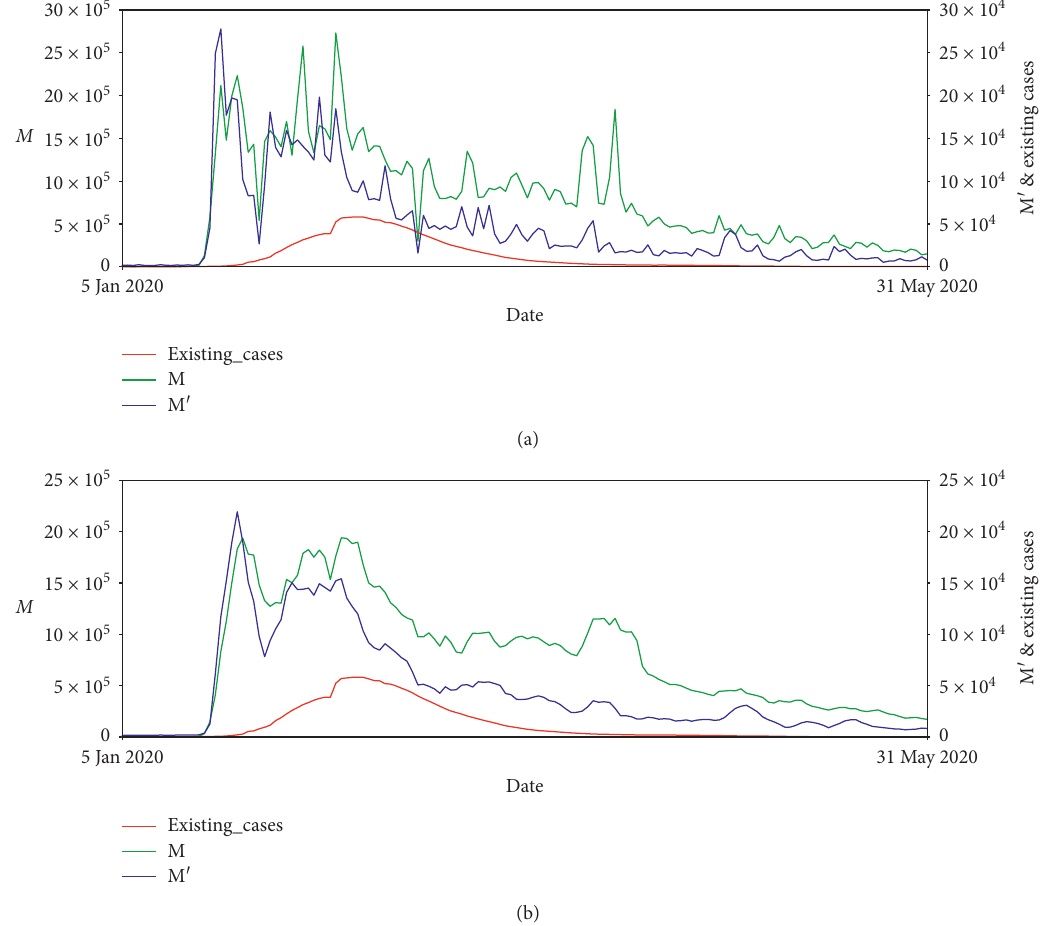
Figure 1: (a) Number of existing cases of COVID-19 in China (red line), number of discussions about COVID-19 (M) (green line), and disinfection on Sina Weibo (M’, blue line). (b) Smoothed curves in (a) using nonoverlapping windows, w �